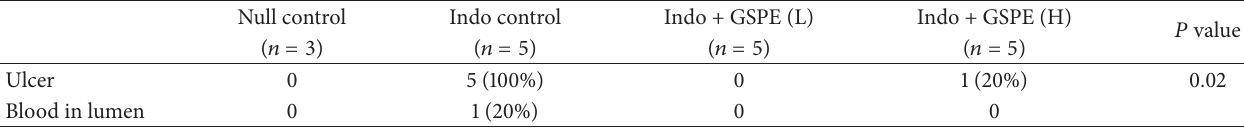
Figure 3: Gross appearance of small intestinal mucosal injury. (a) Multiple rounds, ovoid erosions, and ulcers were scattered in the small intestinal mucosa. Small erosions and ulcers measured from 0.1 mm to 1.5 mm in diameter. (b) A large ulcer created an 11.0mm long circumferential band-like mucosal defect. The wall was thin and appeared transparent with impending perforation. (c) Spotty epithelial hemorrhages and bloody luminal content were present. Table 1: The incidence of indomethacin-induced small intestinal